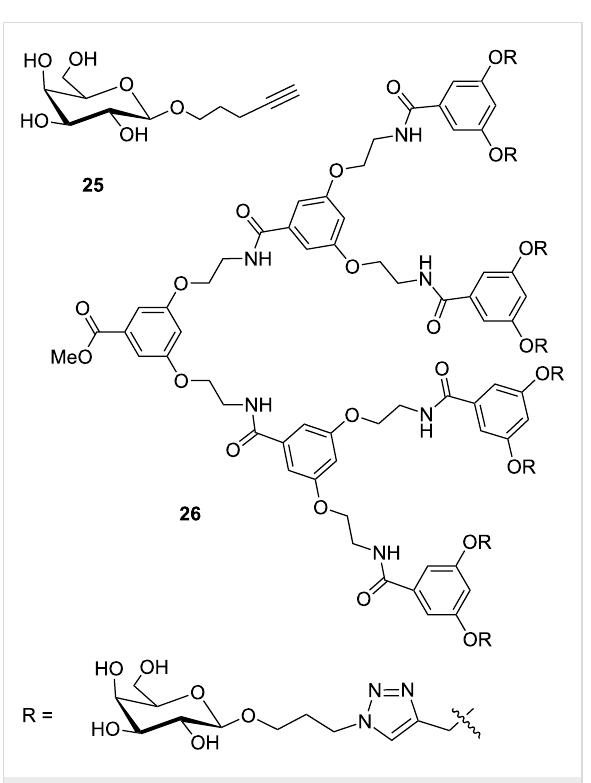
Figure 5: Previously tested